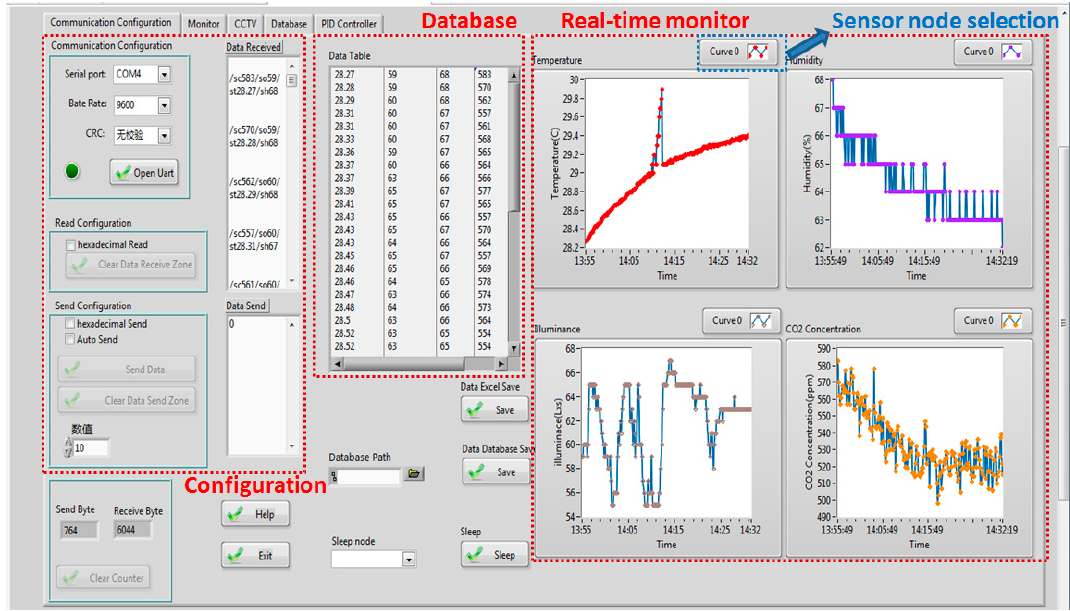
Figure 15. Data synchronization through a browser.